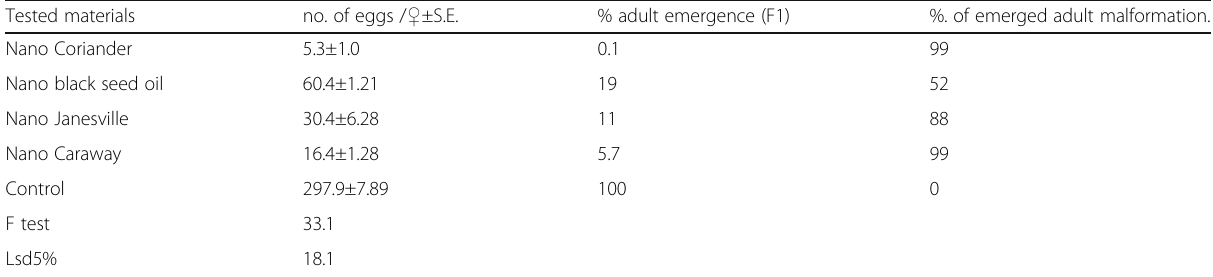
Table 4 Effect of the tested essential oils and nano-oils on eggs number laid per female and % of adult emergence (F1) of T. confusum during storage periods Tested materials no. of eggs / ♀ ±S.E. % adult emergence (F1) %. of emerged adult